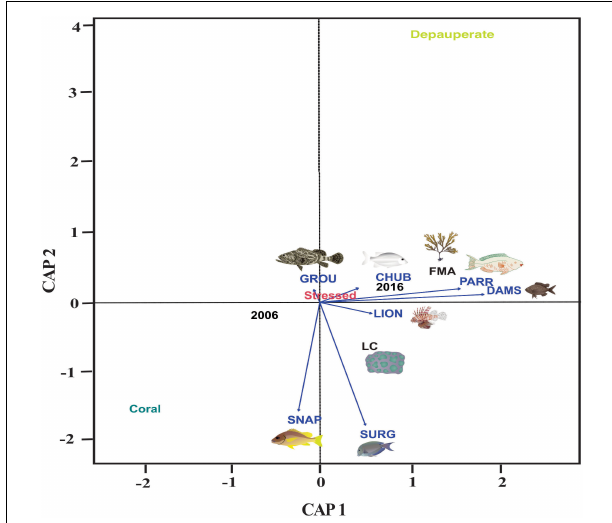
FIGURE 4 | Canonical Analysis of Principal Coordinates of benthic cover dissimilarities represented by live coral (LC) and fleshy macroalgae (FMA) explained by key functional fish density, integrating the benthic state: coral, stressed or depauperate; and the monitoring year: 2006 or 2016. DAMS, algal-gardening damselfish; CHUB, chubs; PARR, parrotfish; SURG, surgeonfish; LION, lionfish; GROU, groupers; SNAP,